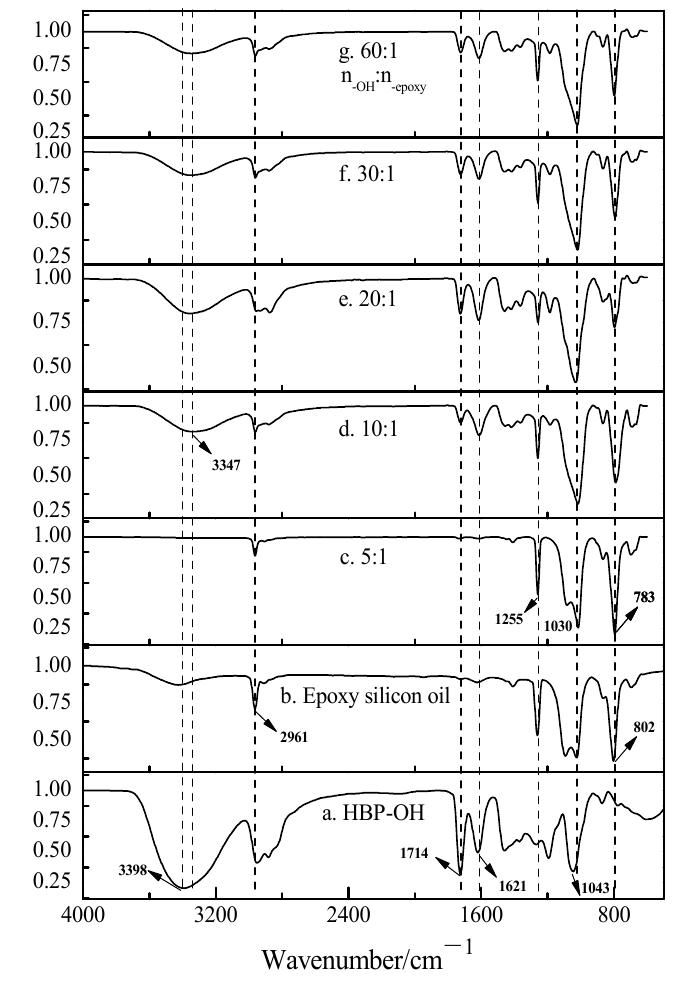
Figure 4. FT ‐ IR spectrum of raw materials and NHSi with different reaction ratio of n ‐ OH :n ‐ epoxy. Figure 4. FT-IR spectrum of raw materials and NHSi with different reaction ratio of n HBP-OH, ( b ) Epoxy silicon oil, ( c ) 5:1, ( d ) 10:1, ( e ) 20:1, ( f ) 30:1, ( g )